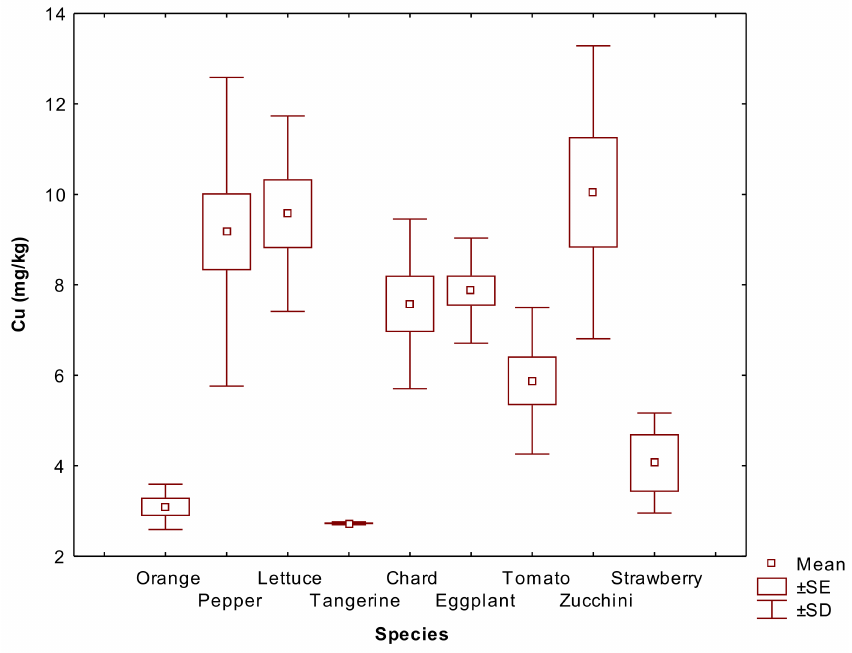
Figure 4. Copper accumulation in the different studied species growing in urban gardens.